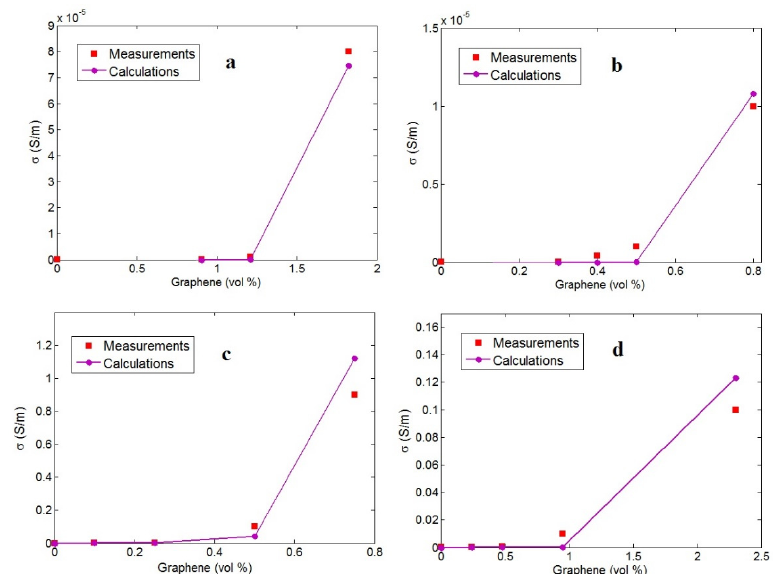
Figure 9. Experimental measurements and predictions using Equation (14) at different filler amounts for ( a ) epoxy [49], ( b ) ABS [50], ( c ) PS [51], and ( d ) PVDF [28] graphene